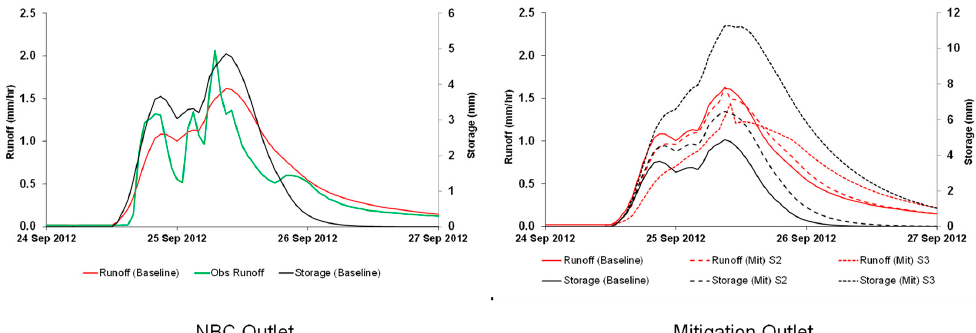
Figure 6. Time series plots of runoff (Q) and storage (S) during Event 3: Left hand (LH) pane shows modelled and observed Q (red) and modelled S (black) for baseline only at the NBC outlet. Right hand (RH) pane shows modelled Q (red) and S (black) at the mitigated sub-catchment outlet with different line types representing the baseline and Scenarios 2 (S2) and 3 (S3).